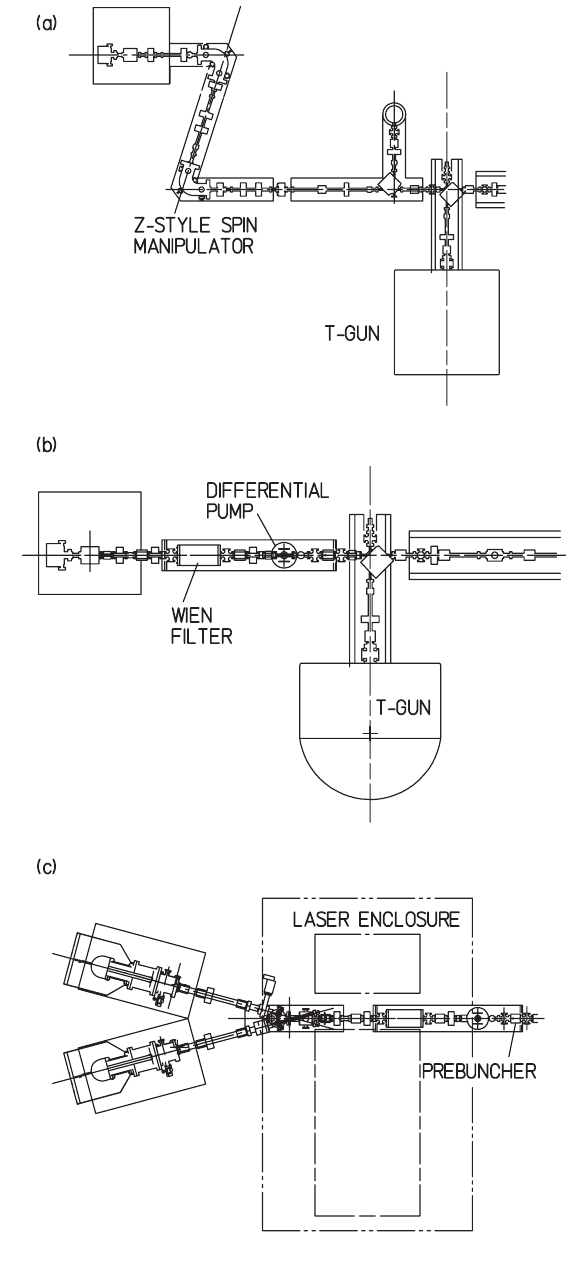
FIG. 5. The three CEBAF photoinjector designs. The photo- guns used for the first and second polarized injectors extend out of the plane of (a) and (b) and are not shown. Today’s photo- injector, (c), is so reliable the thermionic gun (T-gun) has been